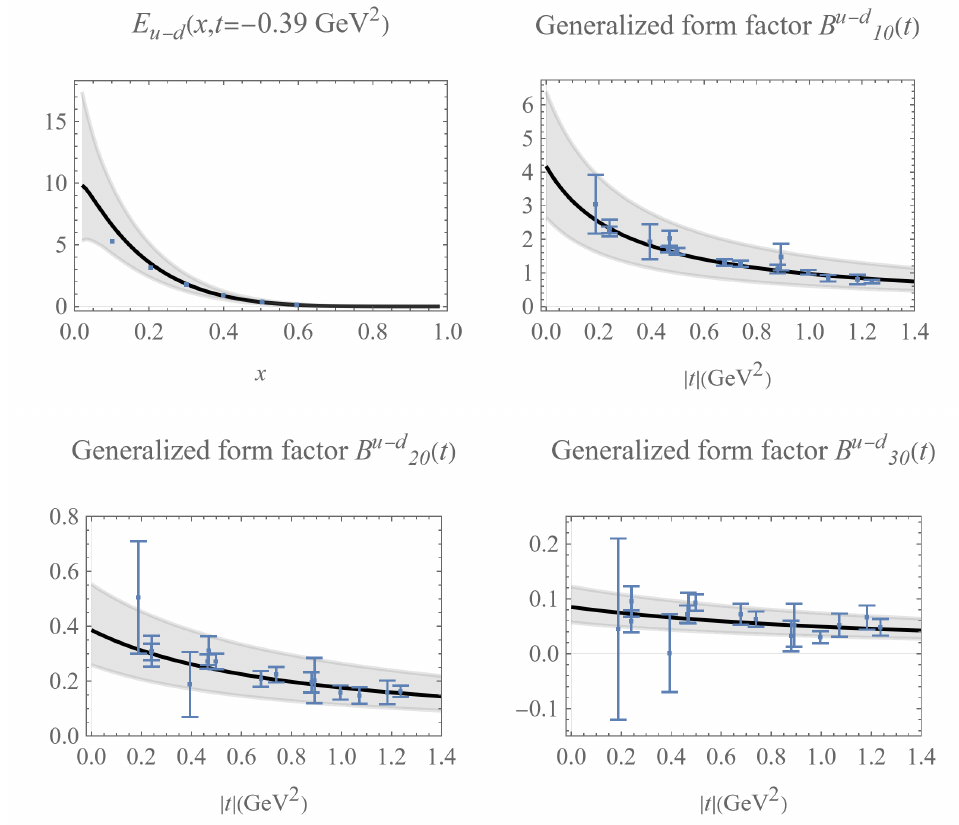
Figure 8 . A simultaneous fit to the t -dependent PDF E u − d ( x ) [40] and generalized form factors B u − d ( t ) , B u − d ( t ) and B u − d ( t ) [32]. The solid lines are the central value of E u − d ( x, t ) , the gray 10 20 30 bands are the regions within 1 σ uncertainty and the dots are measurements that are fitted to. The χ 2 per d.o.f. is 0.8 for our 4 parameters fitting. The parameters from the fitting read N E vec = 6 . 770 (1 . 354) , α E vec = 0 . 437 (62) , β E vec = 4 . 527 (240) and α 0 = 1 . 864 (222) E vec